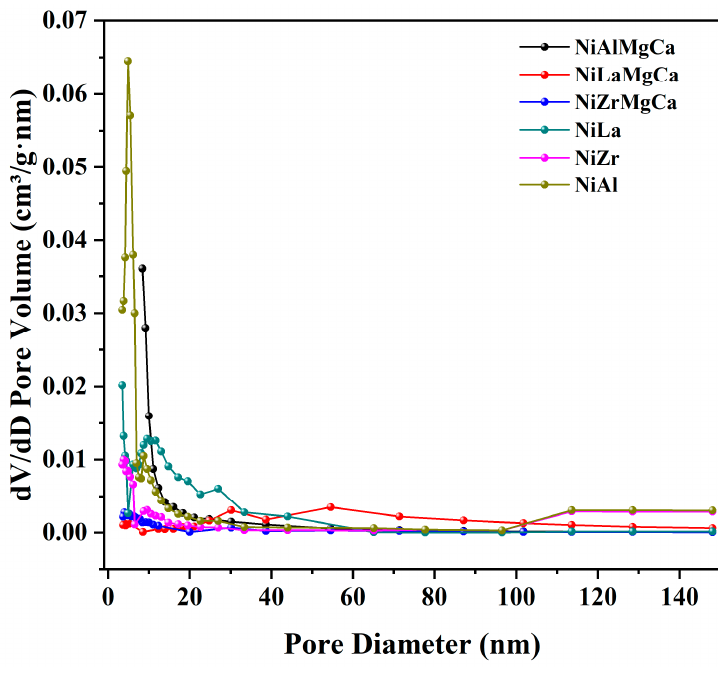
Figure 5. BJH pore size of the reduced catalyst. Table 2. Summary of characterization finding in this study.